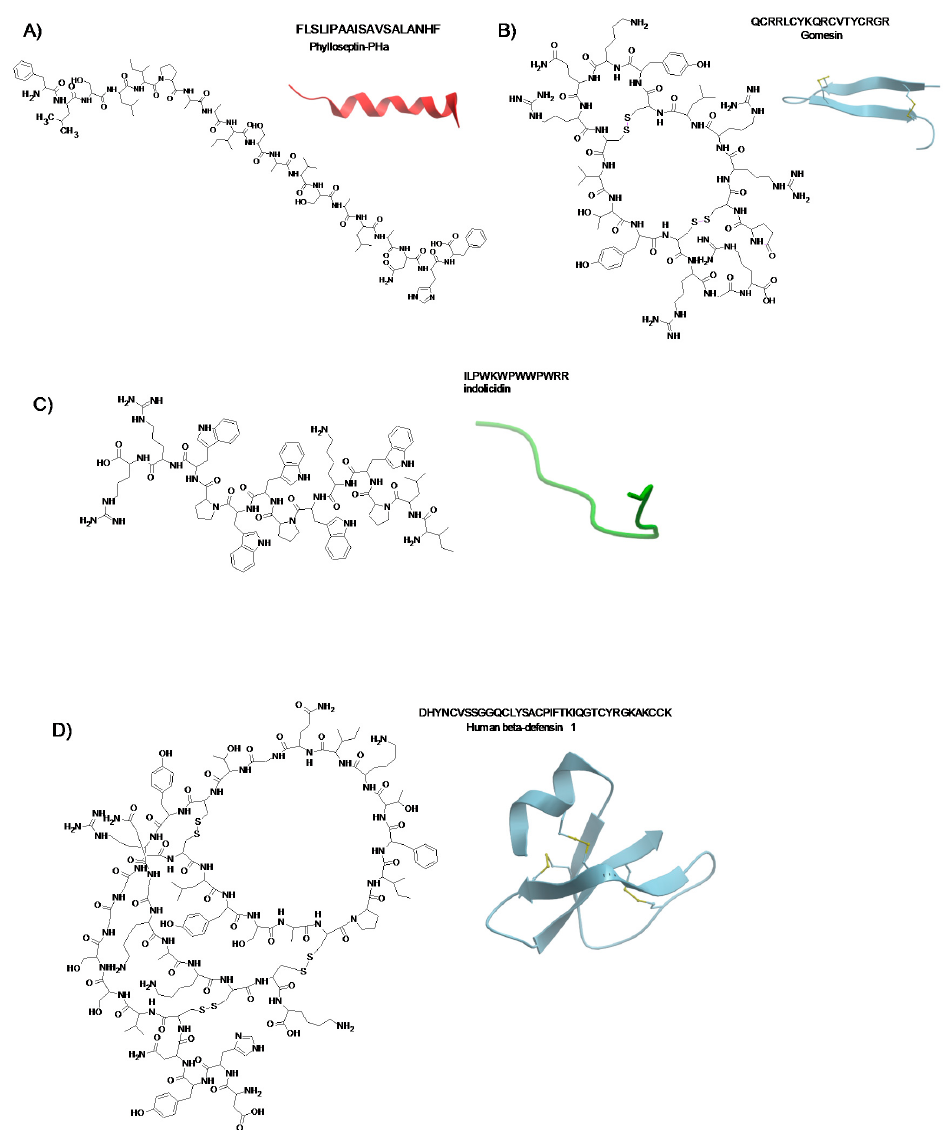
Figure 1. Chemical structures and related secondary structures of the four classes of AMPs: ( A ) Phylloseptin-Pha, α -helix; ( B ) Gomesin, β -strands (two disulfide bounds); ( C ) Indolicidin, unstructured; ( D ) Human beta defensine 1, mixed structure (three disulfide bounds). 3D structures have been generated with ICM-Molbrowser. Physicochemical parameters are reported in http://dramp.cpu-bioinfor.org/ and http://aps.unmc.edu/AP/main.php. The α -helix group comprises the magainins, cecropins, LL-37, temporins, fowlicidins, melittin, while β -sheet peptides include human, plant and insect defensins (type A), plectasin, lactoferricin, tachyplesin, thanatin, and others. The α -helix peptides, containing alanine, leucine and lysine residues to stabilize the helix but not cysteine residues, are the most studied class of AMPs. They have random conformations in aqueous solution and become helical when interact with cell membranes. The β -sheet peptides are rich in proline, glycine, tryptophan, arginine or histidine, and contain from two to ten cysteine residues forming up to five disulphide bridges. Flexible or extended peptides are generally linear, contain infrequent amino acids and include tritrpticin, PR-39, histatins, bactenecins, and indolicidin, the latter being the only molecule that is active towards membranes of pathogenic organisms. Finally, cyclic peptides, such as bacteriocins, acquire the typical conformation through the formation of one or two disulphide bonds